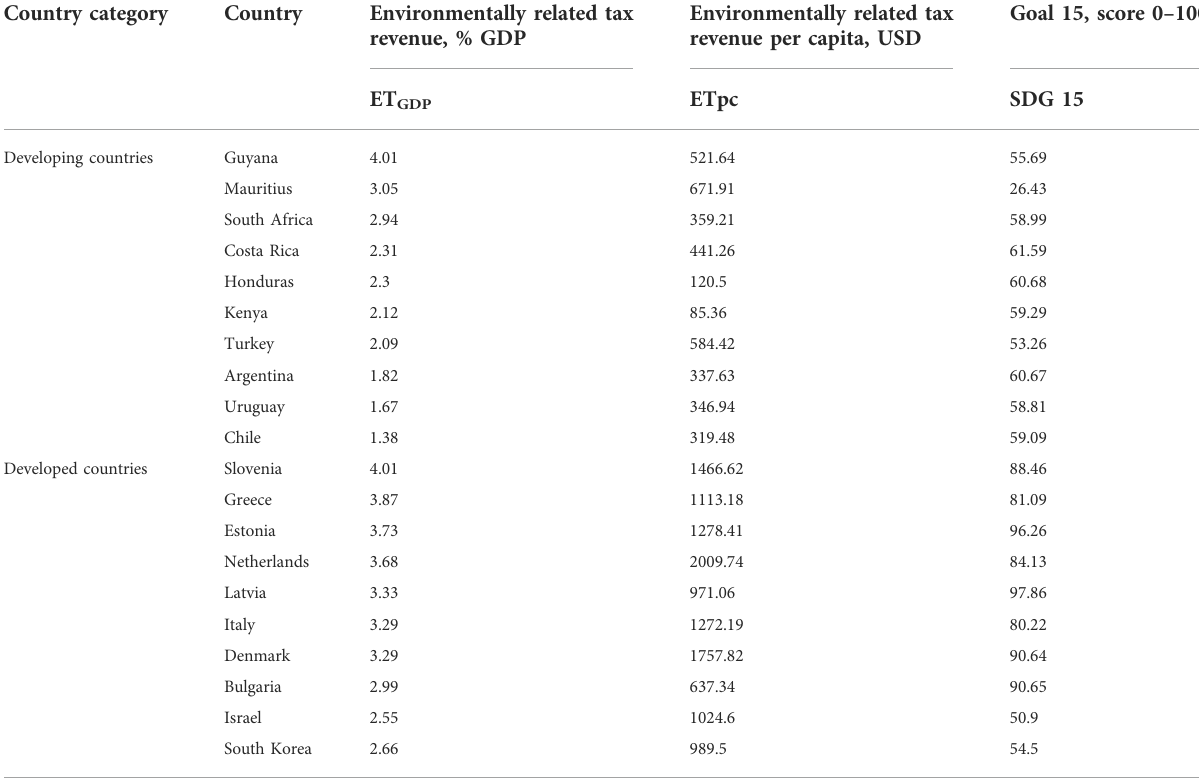
TABLE 1 Environmental taxation in 2019 and the results of the implementation of SDG 15 in 2021 in developed and developing countries. Country